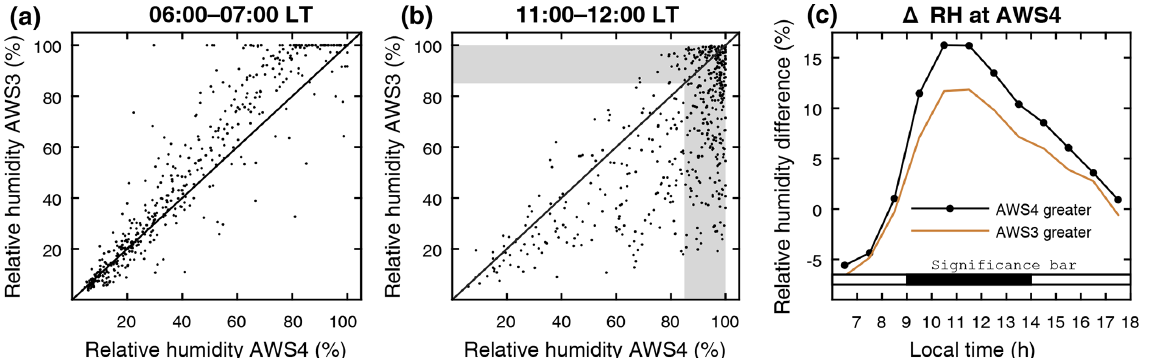
Figure 12. AWS4 vs. AWS3 hourly mean relative humidity at (a) 06:00–07:00LT and (b) 11:00–12:00LT for all days between 8 Octo- ber 2009 and 30 September 2013 when solid precipitation at AWS4 was greater than at AWS3 ( n = 502d; cf. 233 + 269 in Fig. 11). Shading indicates RH > 85% to facilitate discussion in the text. Also, (c) the mean diurnal daytime cycles of the RH excess at the lower station ( (cid:49) RH = RH AWS4 – RH AWS3 ) on the same days (black line) and on all days with the opposite condition (brown; solid precipitation at AWS3 greater than at AWS4). Horizontal bar above the x axis identifies the hours when differences in (cid:49) RH are significant at the 5% level (black fill) in both a two-tailed Wilcoxon rank sum and Kolmogorov–Smirnov